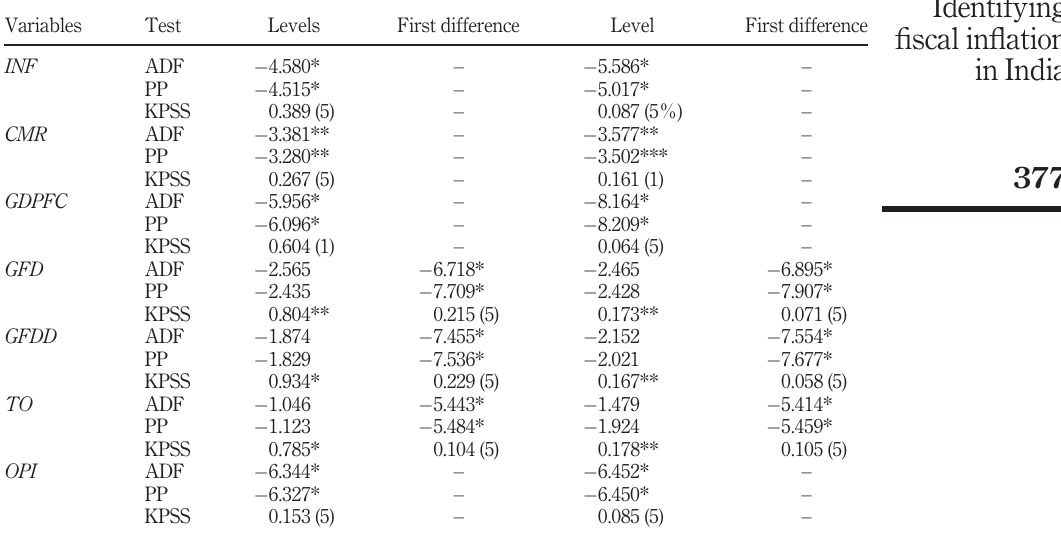
Table 3. Unit root tests